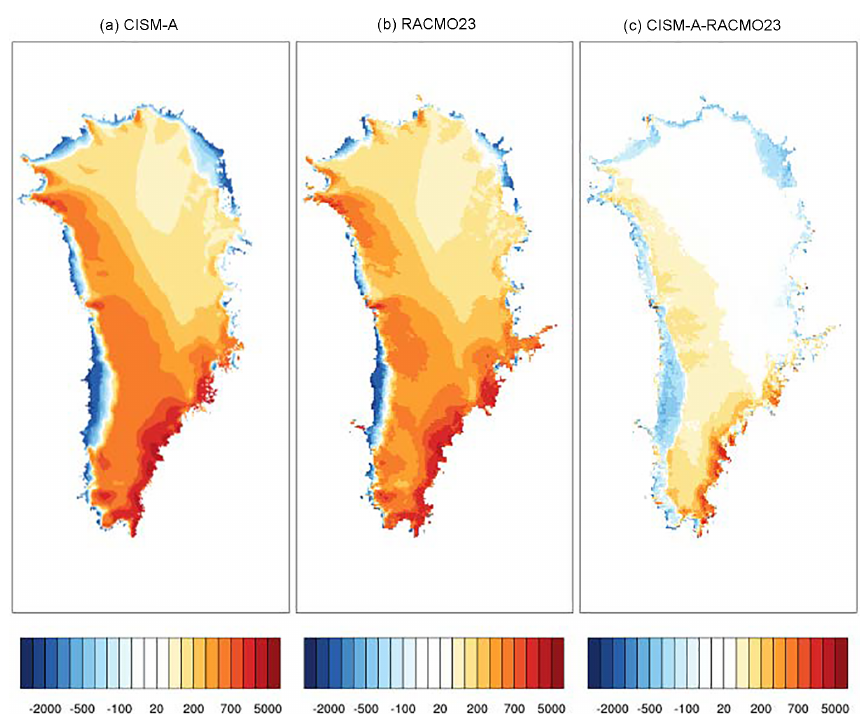
Figure 2. Surface mass balance contours for (a) CISM-A forced with RACMO2.0, (b) RACMO2.3, and (c) CISM-A minus RACMO2.3, with CISM-A interpolated to the coarser RACMO2.3 grid.